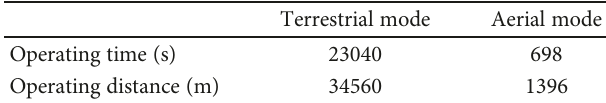
Table 3: Calculated data of operating time and